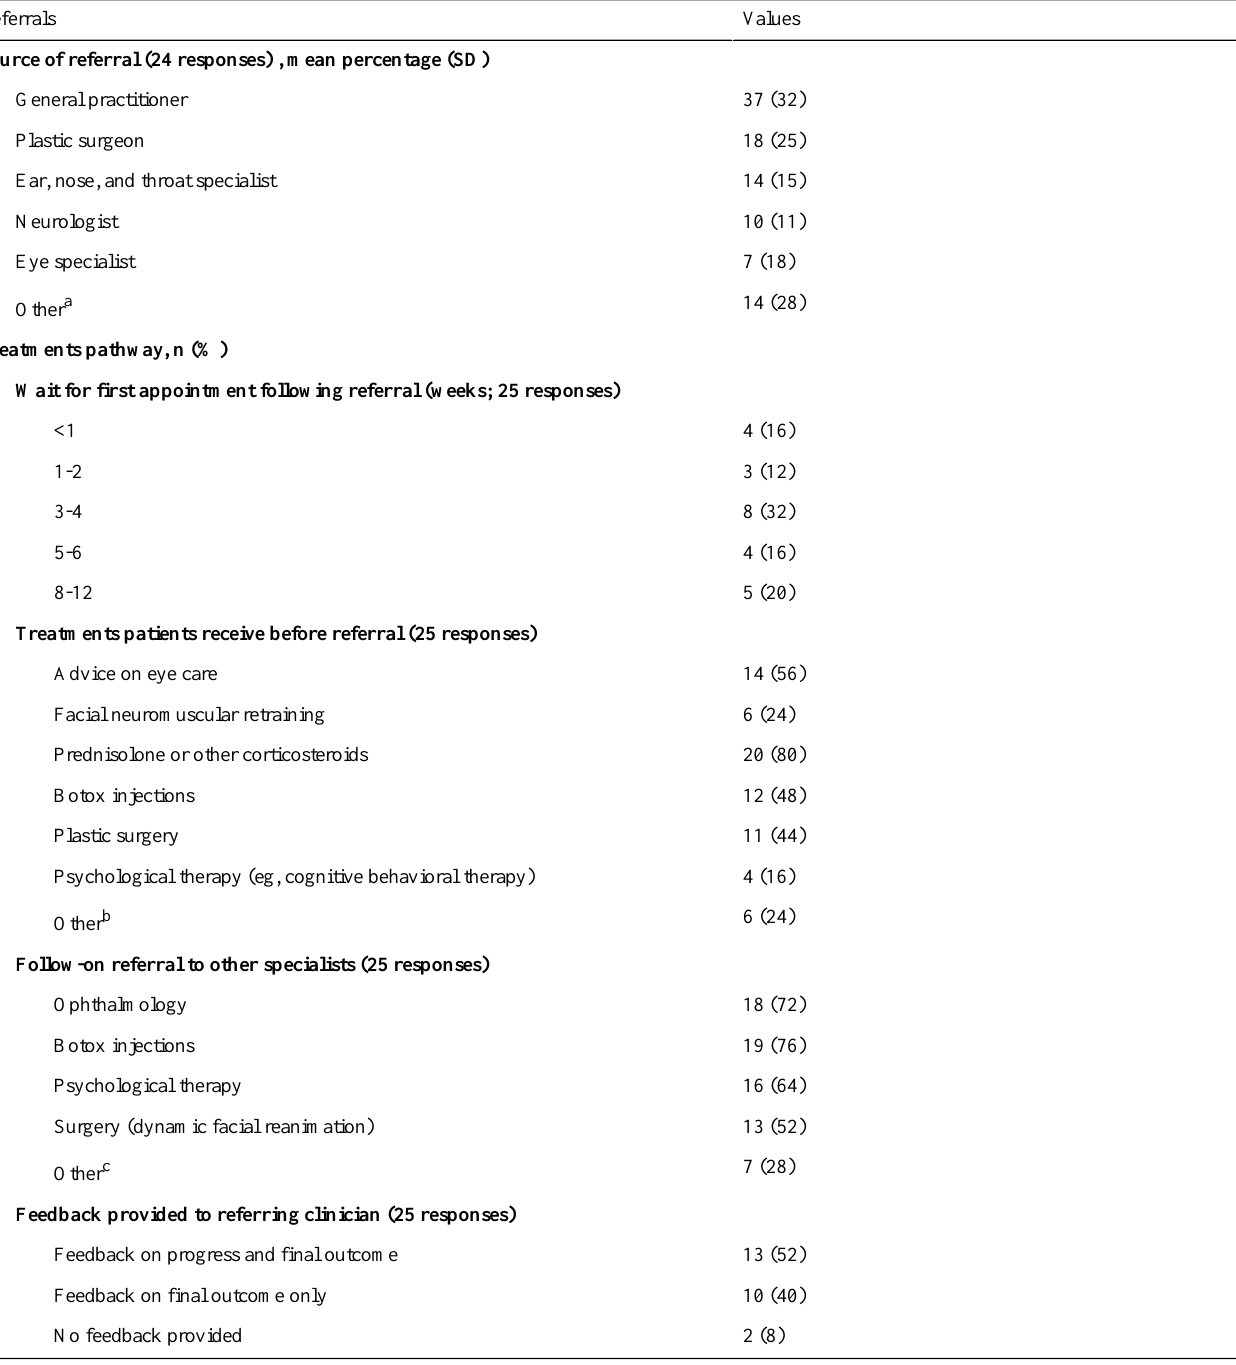
Table 3. Current referral and treatment pathways reported by facial therapy specialists in the United Kingdom.